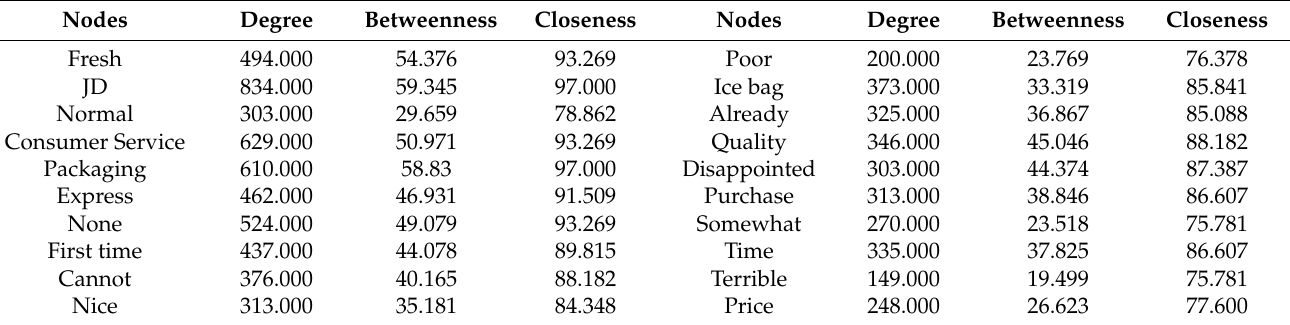
Table 8. Centrality analysis of fresh food e-commerce